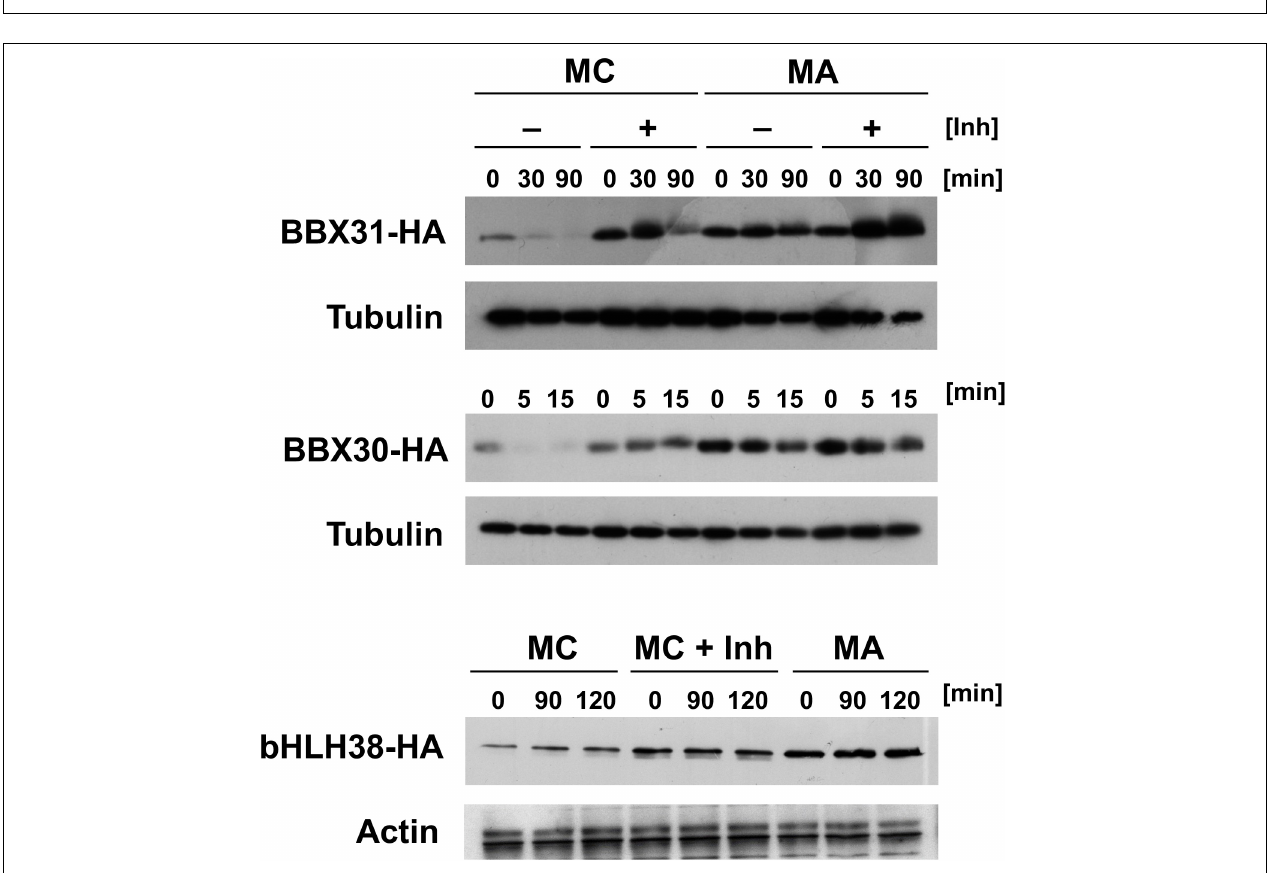
FIGURE 5 | kept at 30 ◦ C to allow yeast growth. Differences are classified by statistical significance ( ∗∗∗ p < 0.001; ∗∗ p < 0.01; ∗ p < 0.05; n.s., not significant, p > 0.05; two-sided t test). At least nine replicates were used for each column. Numerical data are listed in Supplementary File 6 . (D) Western blot with anti-GFP antibody indicates that in all cases, the fusion protein is abundant and detectable. Extracts were taken from a yeast strain expressing PRT6 and AtUBC2. M, marker lane; G, extract expressing unfused GFP. Dots indicate positions of full length fusion proteins.